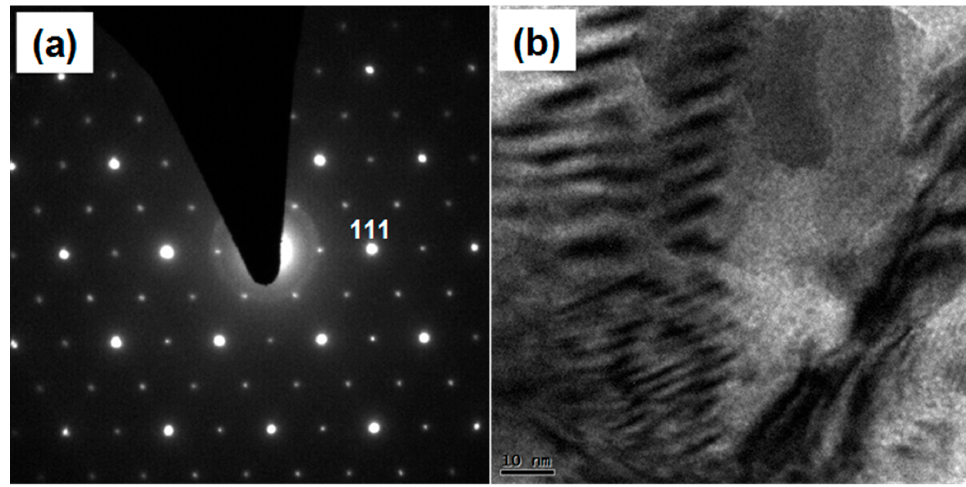
Figure 3. ( a ) Electron diffraction patterns of PLN-0.07PT single crystals exhibiting super-lattice reflections and ( b ) micro-domains configurations under TEM.